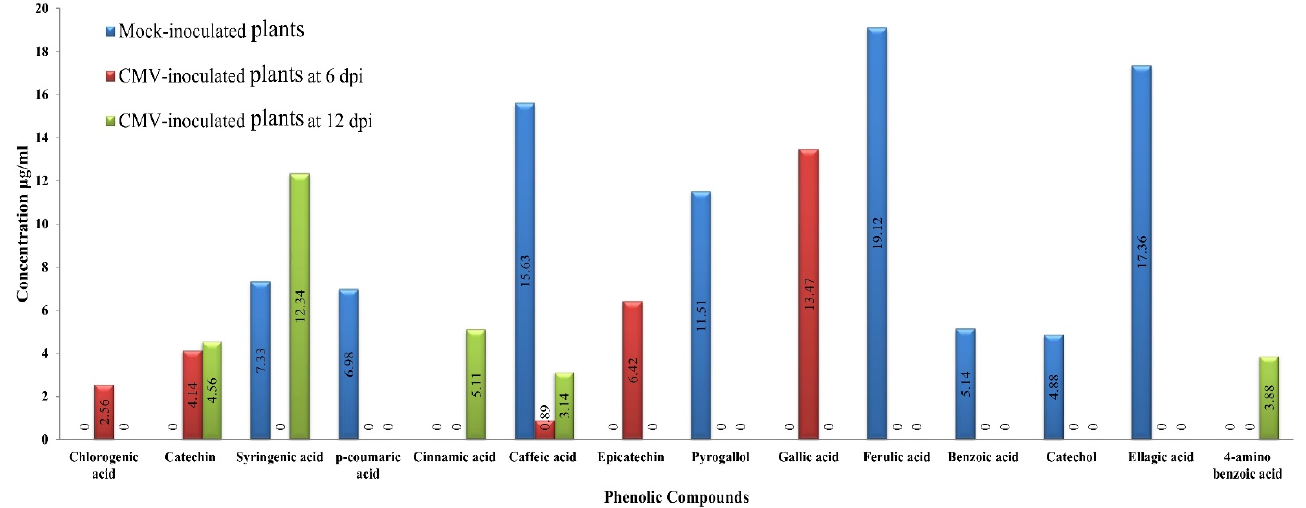
Figure 5. Comparison between the detected phenolic compounds and their concentration ( μ g/mL) in the ethanolic extract of the squash plants in mock-inoculated plants and CMV-inoculated plants at 6 and 12 dpi.